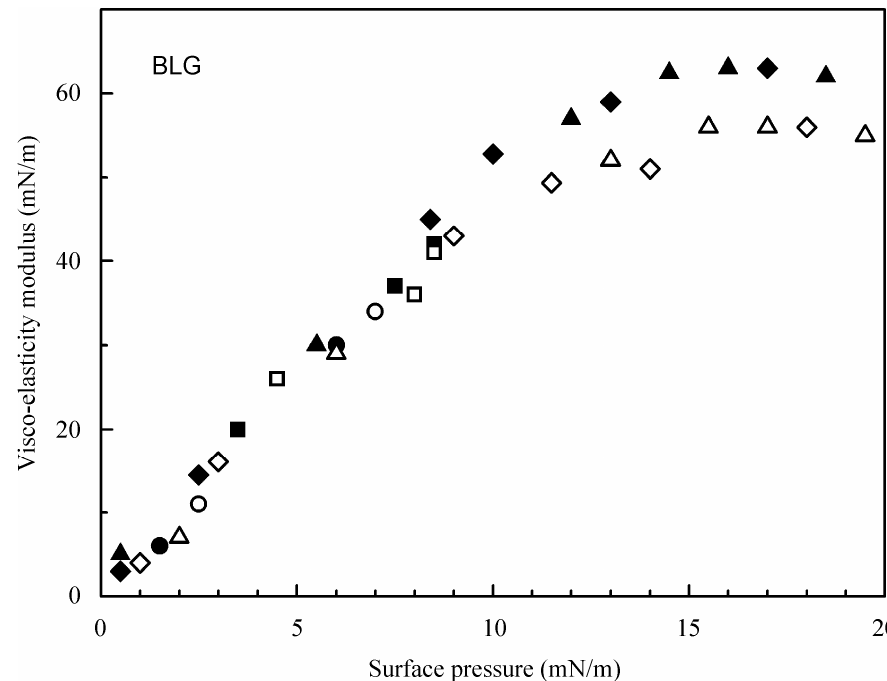
Figure 2. The same as in Figure 1 but for BLG solutions.